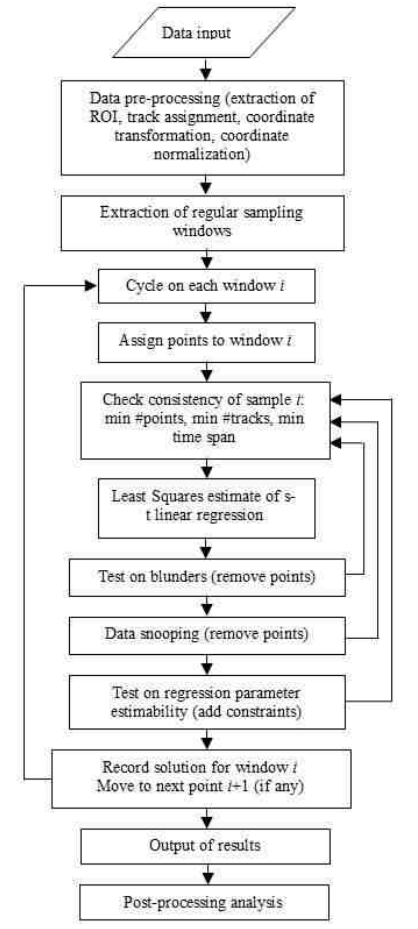
Figure 4. Workflow of the space-temporal linear regression method for estimating elevation change rate over ice-